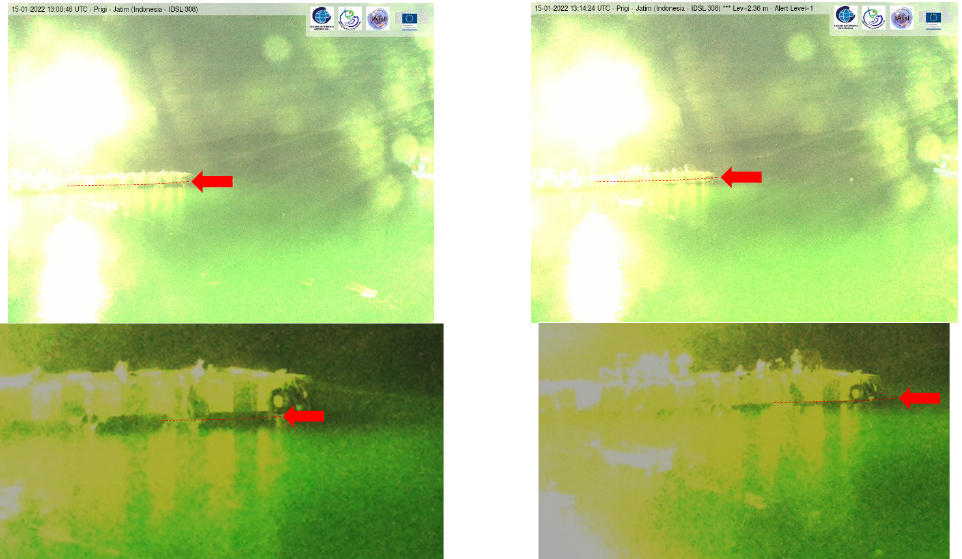
Figure 15. Two snapshots from the IDSL-308 (Prigi, Indonesia) webcams at 13:00:00 UTC, before the arrival of the pressure wave from the Hunga Tonga volcanic eruption at 13:14:24 UTC, as activated by the alerting algorithm. Despite the unfavourable light conditions during the night, it is still pos- sible to note the sudden rise in sea level.